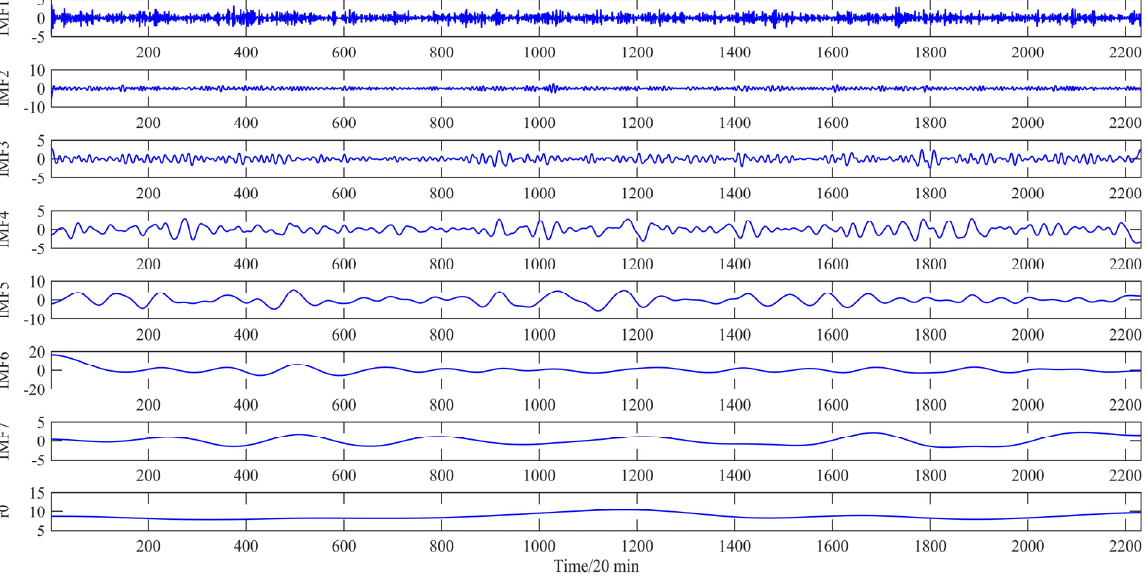
Figure 4. The decomposition of the wind speed during the period from 1 January to 31 January 2011 by FEEMD.